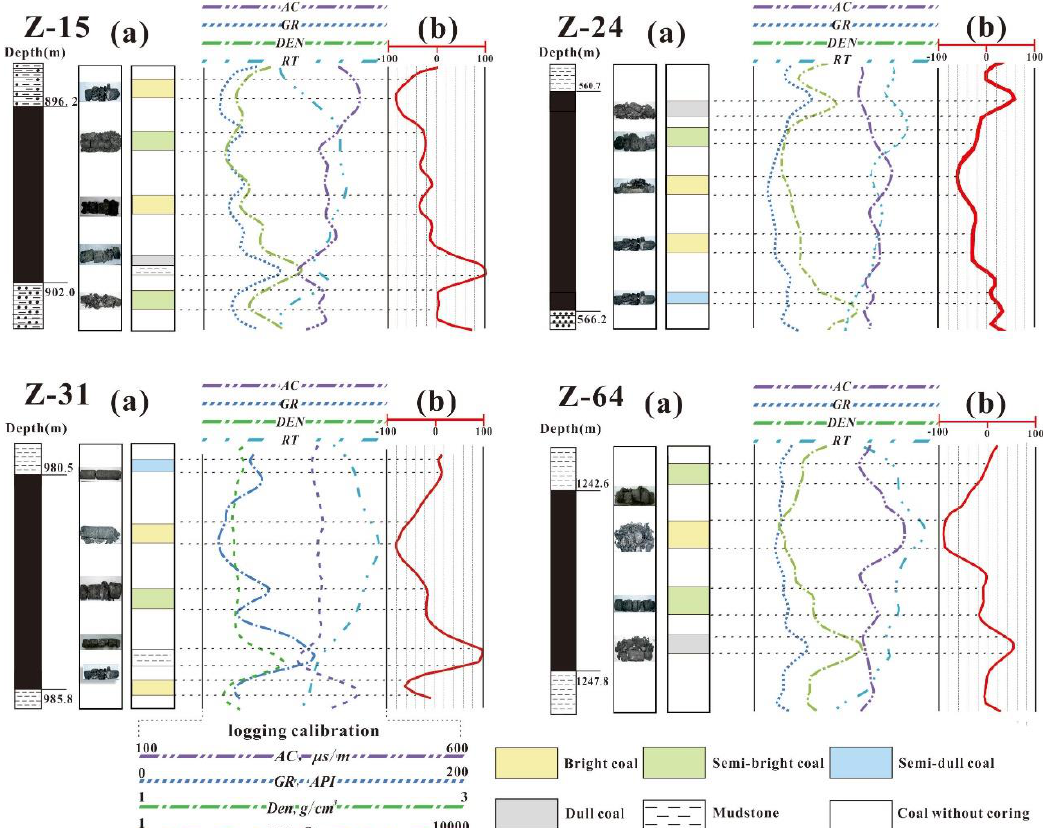
Figure 4. Vertical variations of coal macrolithotypes results identified from the core record corresponding to L-Index ( a —coal cores, b —identification by L-Index). Energies 2021 , 14 , x FOR PEER REVIEW